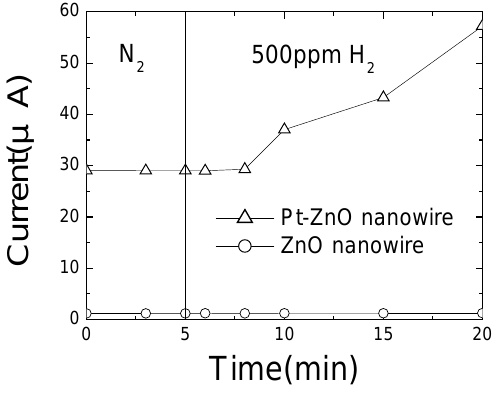
Figure 17. I versus time plot for single ZnO nanorods either with or without Pt coatings (top) and corresponding | ∆ R|/R(%)-time